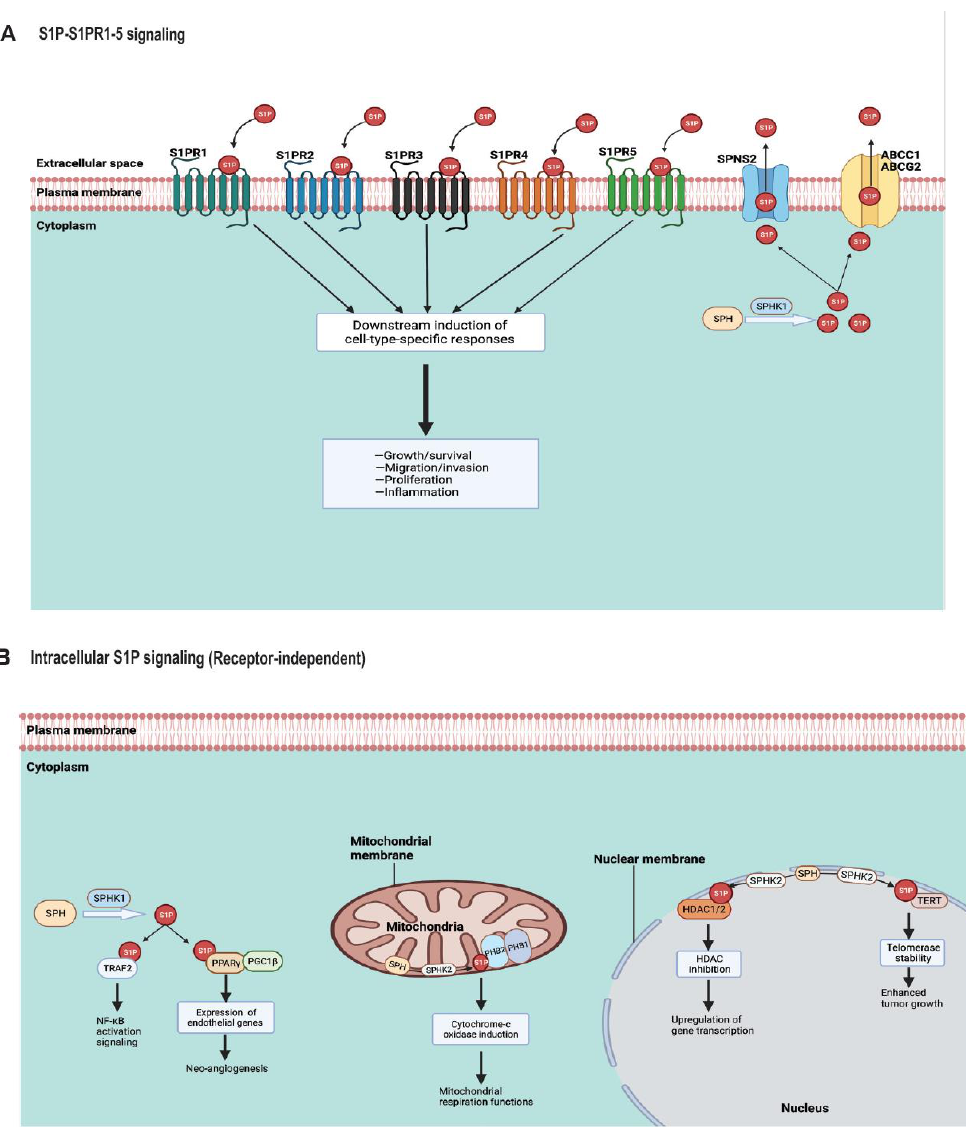
Figure 4. S1P receptor and receptor-independent signaling. ( A ) SPHK1 catalyzes the synthesis of S1P from SPH in the cytoplasm. S1P then exit the cytoplasm and into the extracellular space via SPNS2, ABCC1, or ABCG2 transporters. The secreted S1P can engage the five known S1P specific G protein-coupled receptors (S1PR1 – 5) for cellular signaling leading to a downstream induction of cell-type-specific responses to stimulate cell growth/survival, migration/invasion, proliferation, and/or inflammation. ( B ) S1P can also function independent of S1PRs. In the cytoplasm, SPHK1- generated S1P can bind TRAF2 at the N-terminal RING domain, leading to NF- κB signaling activa- tion downstream. SPHK1- derived S1P can also bind and activate PPARγ , which then allows for the recruitmen t of PGC1β, to form the SlP/PPARγ/PGC1β complex, inducing PPARγ -dependent genes and neo-angiogenesis. SPHK2-generated S1P in the mitochondria can bind homomeric PHB2 with- out binding to PHB1 to induce cytochrome c oxidase or complex IV and mitochondria respiration functions. In the nucleus, SPHK2-derived S1P can bind HDAC1 and HDAC2, inhibiting their activ- ities to stimulate the upregulation of gene transcriptions. Additionally, SPHK2-generated S1P can also bind TERT in the nuclear membrane to stabilize telomerase and enhance tumor growth. SPH, sphingosine; SPHK1, sphingosine kinase 1; SPHK2, sphingosine kinase 2; S1P, sphingosine-1-phos- phate; SPNS2, protein spinster homolog 2; ABCC1, ATP-binding cassette sub-family C member 1; ABCG2, ATP-binding cassette sub-family G member 2; S1PR, sphingosine-1-phosphate receptor; TRAF2, TNF receptor-associated factor 2; NF- κB, nuclear factor - κB; PPARγ, peroxisome prolifera- tor-activated receptor- γ; PGC1β, PPARγ co - activator 1β; PHB1, prohibitin 1; PHB2, prohibitin 2; HDAC1, histone deacetylase 1; HDAC2, histone deacetylase 2; TERT, telomerase reverse-transcrip- tase.